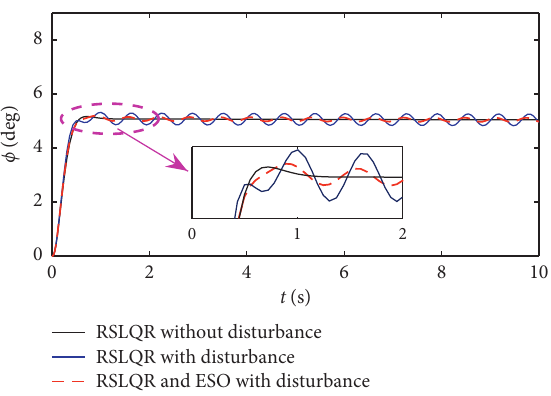
Figure 12: Comparison of the roll angle response based on RSLQR under disturbance-free conditions, under disturbance conditions without ESO, and under disturbance conditions with ESO.